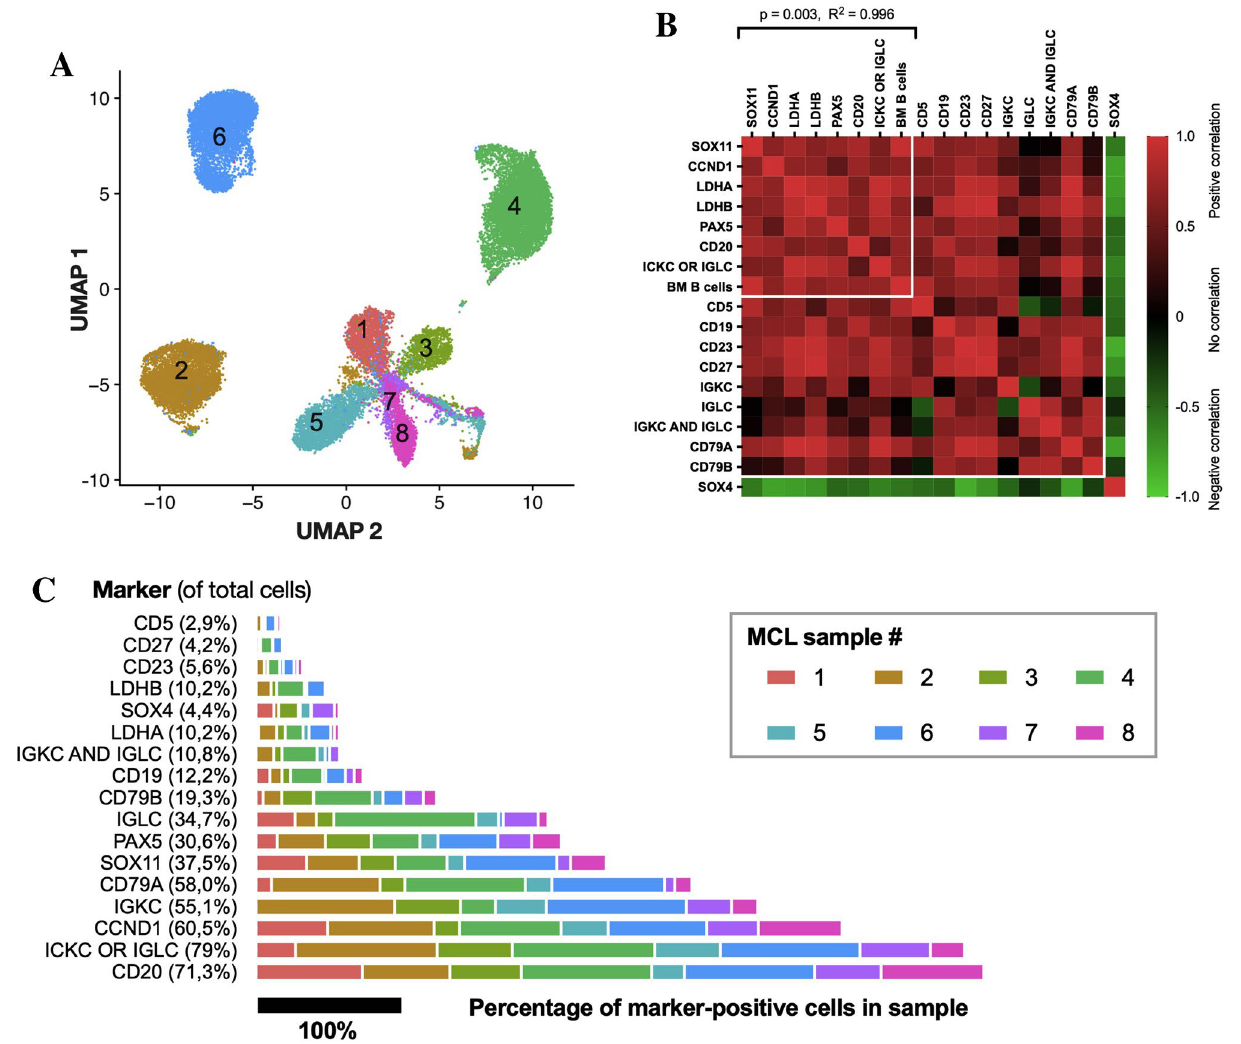
positive for CCND1, CD20 and κ/λ (IGKC/IGLC), while merely 37.5% of the total sequenced cells were SOX11 + , varying from 9.8 to 64.6%. 10.8% of the combined cohort was found to harbor dual expression of κ